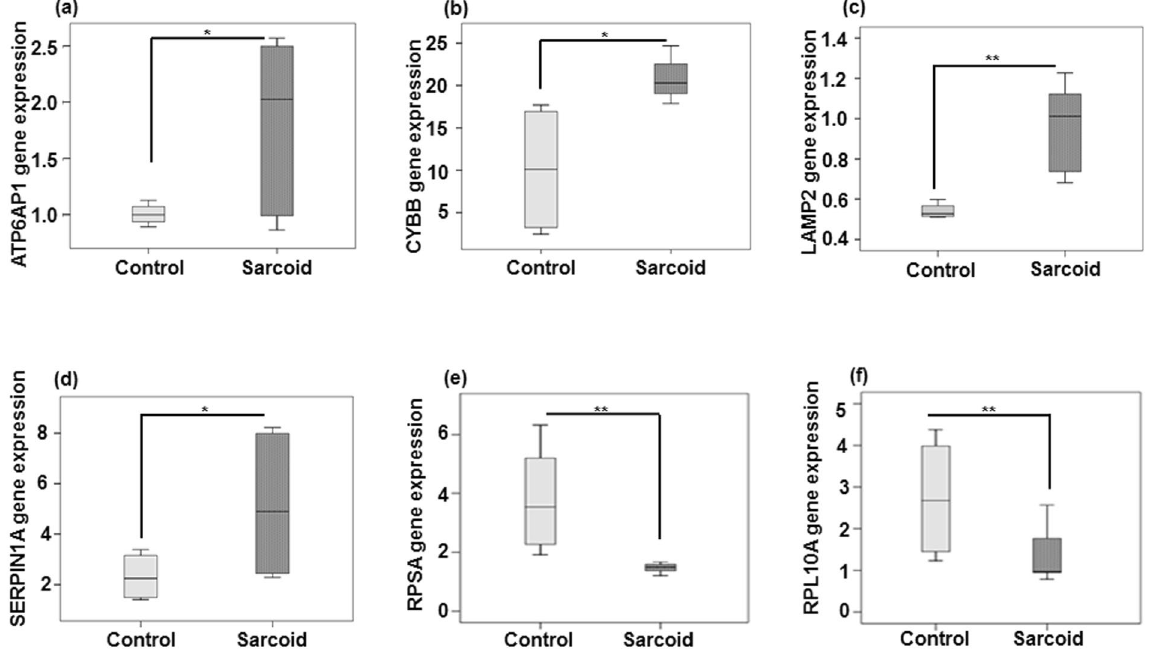
Figure 6. Validation of RNA-seq data by qRT-PCR. Total RNA was extracted from the monocytes from independent sets of 10 sarcoidosis patients and 10 healthy controls. Isolated RNAs were and reverse-transcribed using the Reverse Transcription System. The primers targeted ( a ) ATP6AP1, ( b ) CYBB, ( c ) LAMP2, ( d ) SERPIN1A, ( e ) RPSA and ( f ) RPL10A to amplify cDNA using iQSYBR Green Supermix. Relative mRNA levels were calculated by normalizing to β -actin. Box plots represent the normalized expression level of each gene of monocytes of healthy controls and sarcoidosis monocytes. Data were analyzed using the paired, two-tailed Student’s t test and the results were expressed as fold change. * Represents a p value < 0.05 and ** signifies a p <